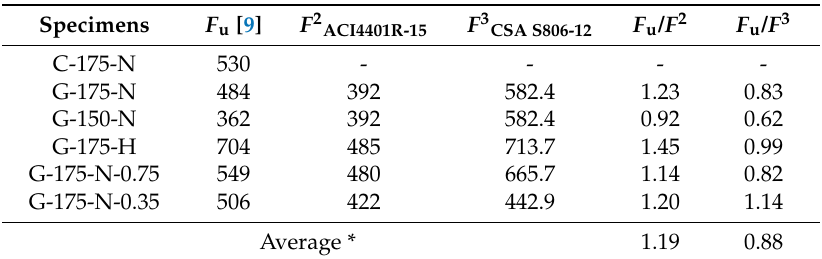
Table 6. Prediction and comparison results of previously tested specimens